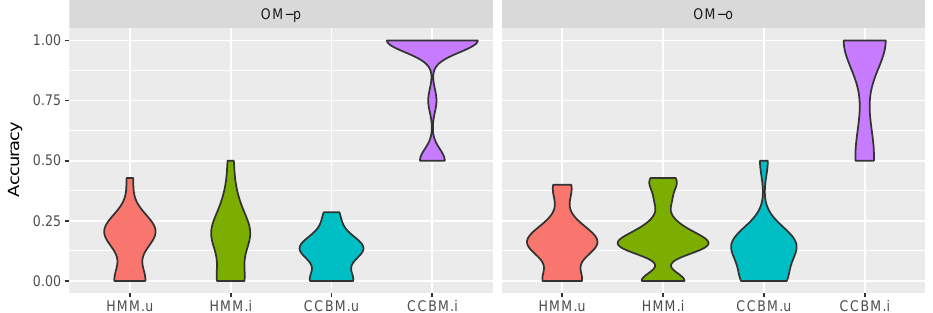
Figure 12. Multigoal recognition results, meal goals. OM-o refers to the optimistic observation model, OM-p to the pessimistic observation model, HMM.u is the HMM with uninformed a priori goal probabilities, HMM.i is the HMM with informed a priori goal probabilities, CCBM.u is the CCBM with uninformed a priori goal probabilities, and CCBM.i is the CCBM with informed a priori goal